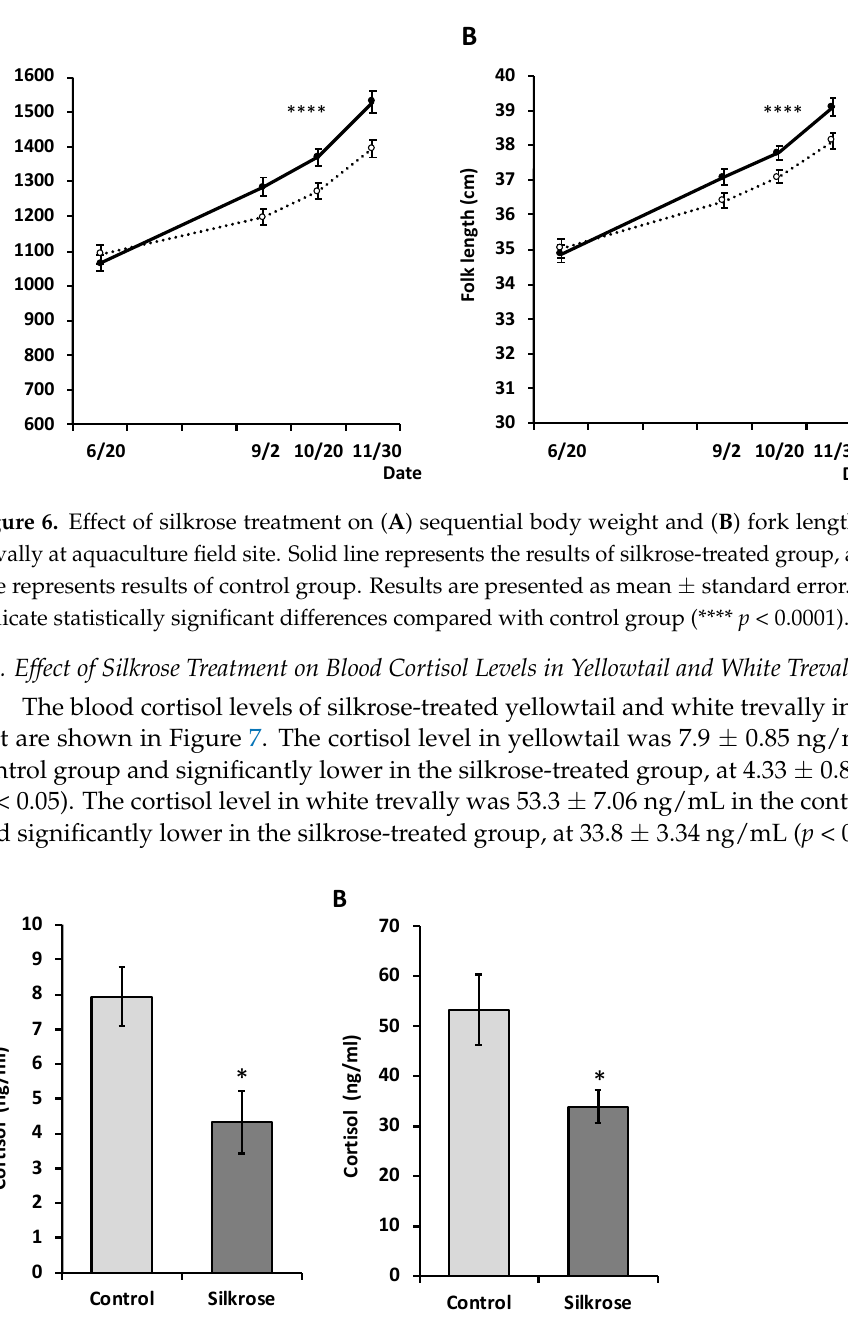
Figure 7. Effect of silkrose treatment on blood cortisol levels in ( A ) cultured yellowtail and ( B ) white trevally. Results are presented as mean ± standard error. Asterisk indicates statistically significant differences compared with control group (* p < 0.05).